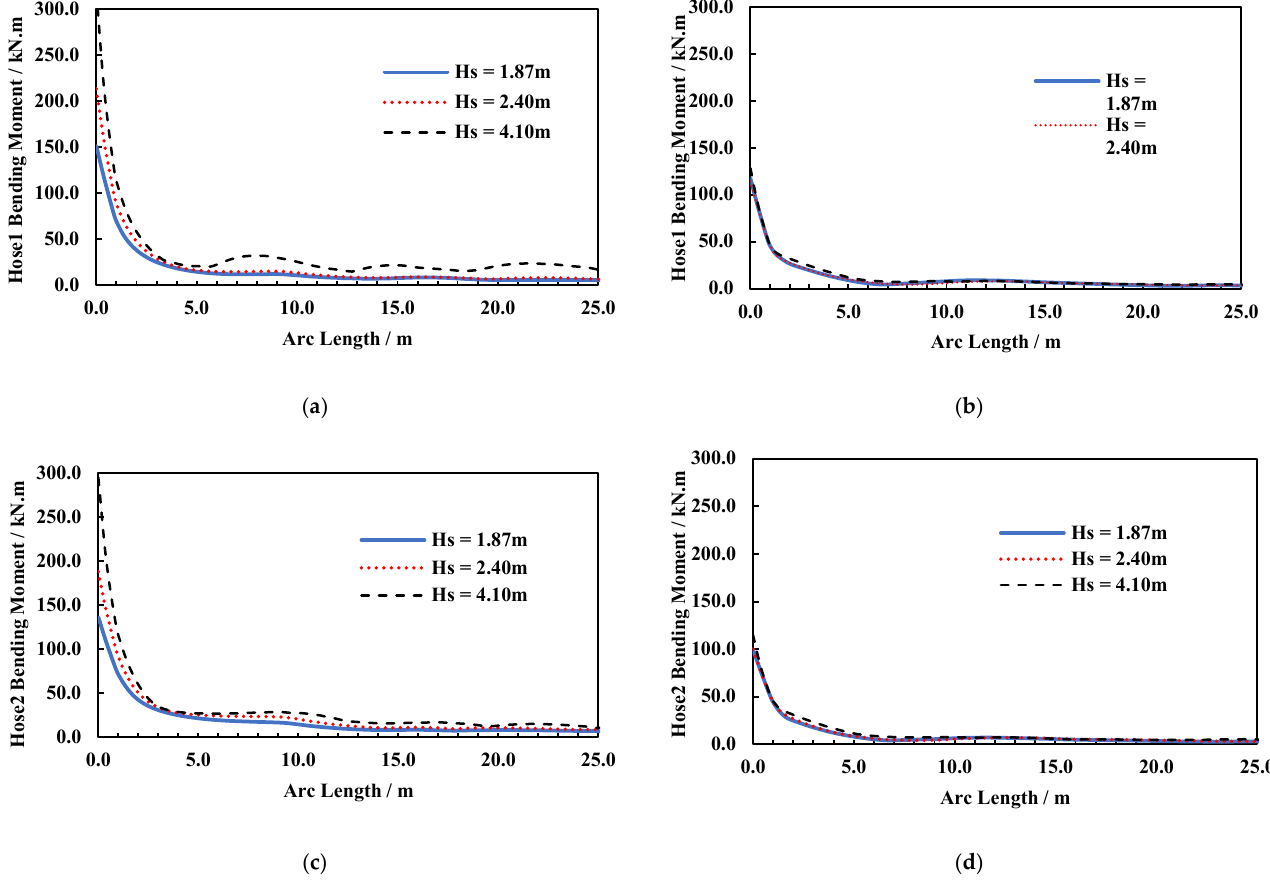
Figure 24. Influence of RAOs on bending moments for different environmental cases . Figures ( a , c ) are when the hoses have RAO loads, while Figures ( b , d ) are when the hoses are without RAO loads for the submarine hoses in Lazy-S. ( a ) Hose1 Bending Moment including hose hydrodynamic load. ( b ) Hose1 Bending Moment excluding hose hydrodynamic load. ( c ) Hose2 Bending Moment including hose hydrodynamic load. ( d ) Hose2 Bending Moment excluding hose hydrodynamic load.